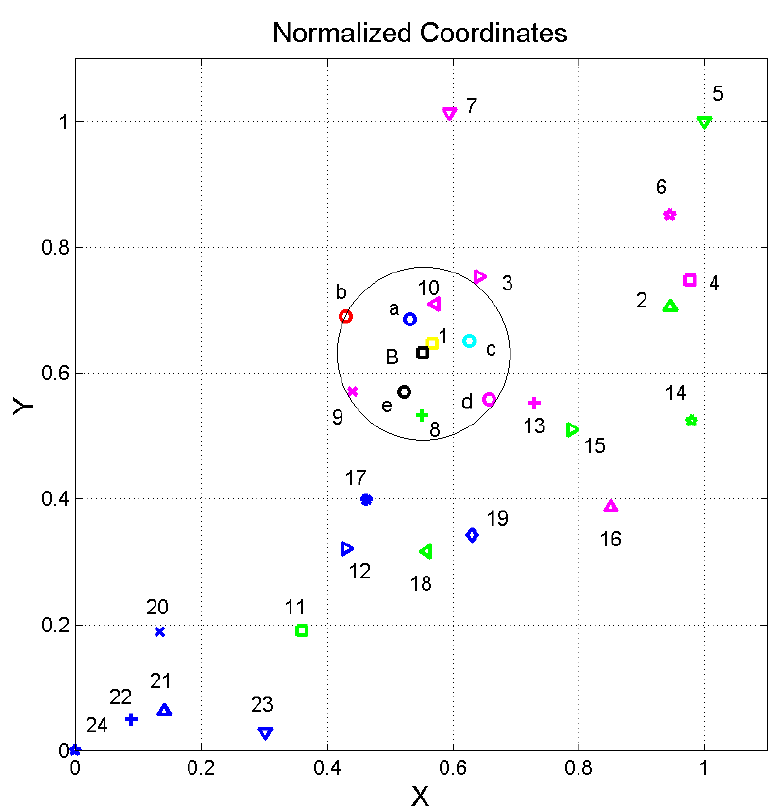
Figure 2. Normalized coordinates 𝑥 and 𝑦 of the resulting vector (18) of the literary works listed in Tables 1 and 2, normalized so that Of Mice and Men is located at the origin (0,0) and Moby Dick is located at (1,1). Dickens’ novels are represented by the circles: The Adventures of Oliver Twist , a , blue; David Copperfield , b , red; Bleak House , d , magenta; A Tale of Two Cities , c , cyan; Our Mutual Friend , e , black. Matthew : 1, yellow square. The black square B is the barycenter of Dickens’ works. The other novels are numbered according to the order reported in Table 2.